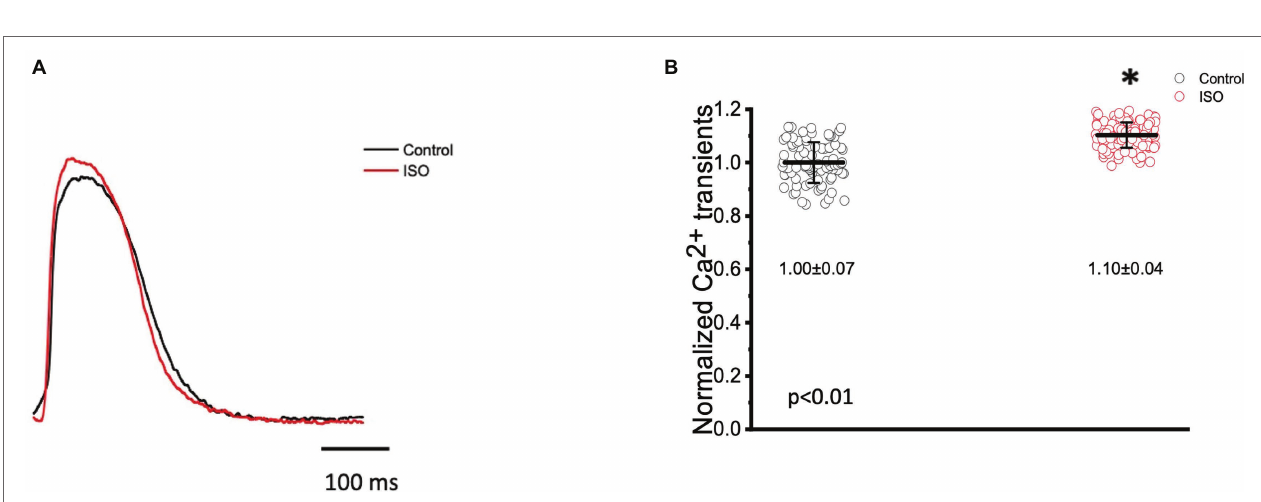
FIGURE 4 | Perfusion with 100 nm isoproterenol significantly altered the time course of all three components in the Goldfish electrocardiogram. The duration of the QRS complex significantly decreased from 22.70 ± 1.30 ms to 17.30 ± 2.80 ms ( p < 0.01, n = 80 for the control, n = 121 for ISO, N = 6; A ), T wave significantly increased from 164.70 ± 53.20 ms to 292.10 ± 58.10 ms ( p < 0.01, n = 110 for the control, n = 120 for ISO, N = 6; B ), and the J wave significantly increased from 126.10 ± 42.30 ms to 333.10 ± 105.30 ms ( p < 0.01, n = 74 for the control, n = 118 for ISO, N = 6; C ). * Denotes a significant difference between the two distributions. The data are presented as multiple measurements (n; dot cloud) recorded for different measurements ( n ) on different hearts ( N ) with the mean ± SEM (solid lines).